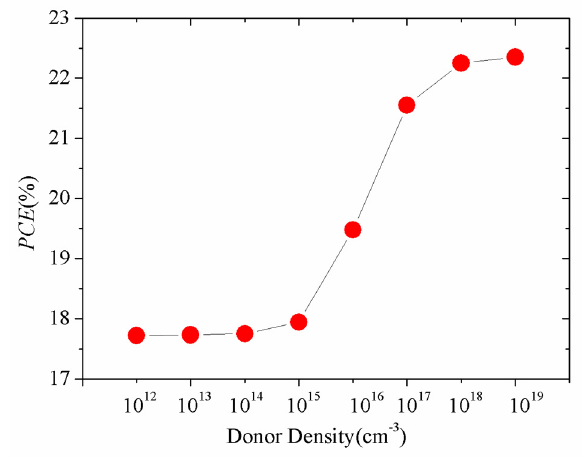
Figure 13. Effect of ETL donor doping density on PCE.